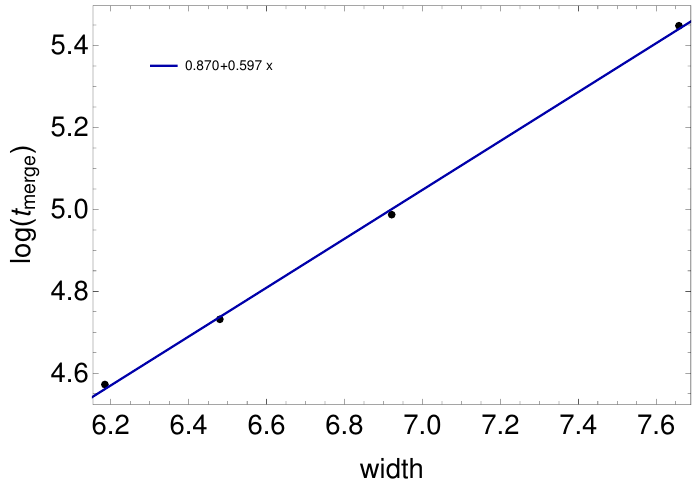
Figure 6 . Merging time as a function of the width of the domain of the low energy phase.